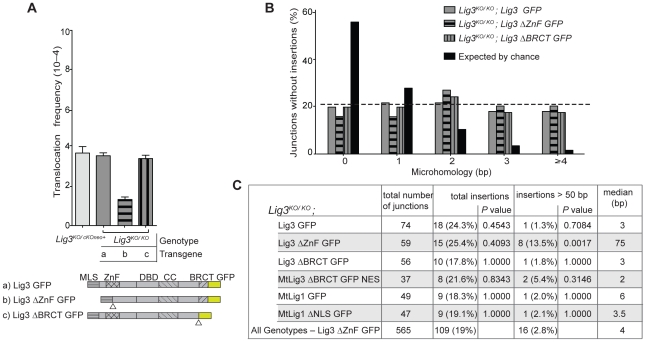
Analysis of Lig3 domain requirements in translocation formation.(A) Deletion of the Lig3 BRCT domain has no effect on translocation frequency, while deletion of the Lig3 ZnF domain reduces translocations. Triangles denote the deletions of the indicated domains. ΔZnF, deletion of Lig3 amino acids 89 to 258 including the ZnF itself and additional sequences which corresponds to a previously described Lig3 ΔZnF mutant [37], [38]; ΔBRCT, deletion of Lig3 amino acids 934 to 1009. (B) Microhomology length distributions in translocation junctions are similar in cells expressing wild-type Lig3 and those expressing either ZnF or BRCT deletions of Lig3. (C) Large, complex insertions are more frequent in cells expressing Lig3 deleted for the ZnF domain. The summary “All Genotypes – Lig3 ΔZnF” denotes all junctions analyzed except those from Lig3KO/KO; Lig3 ΔZnF cells. P values are calculated relative to this group with a Fisher's exact test.